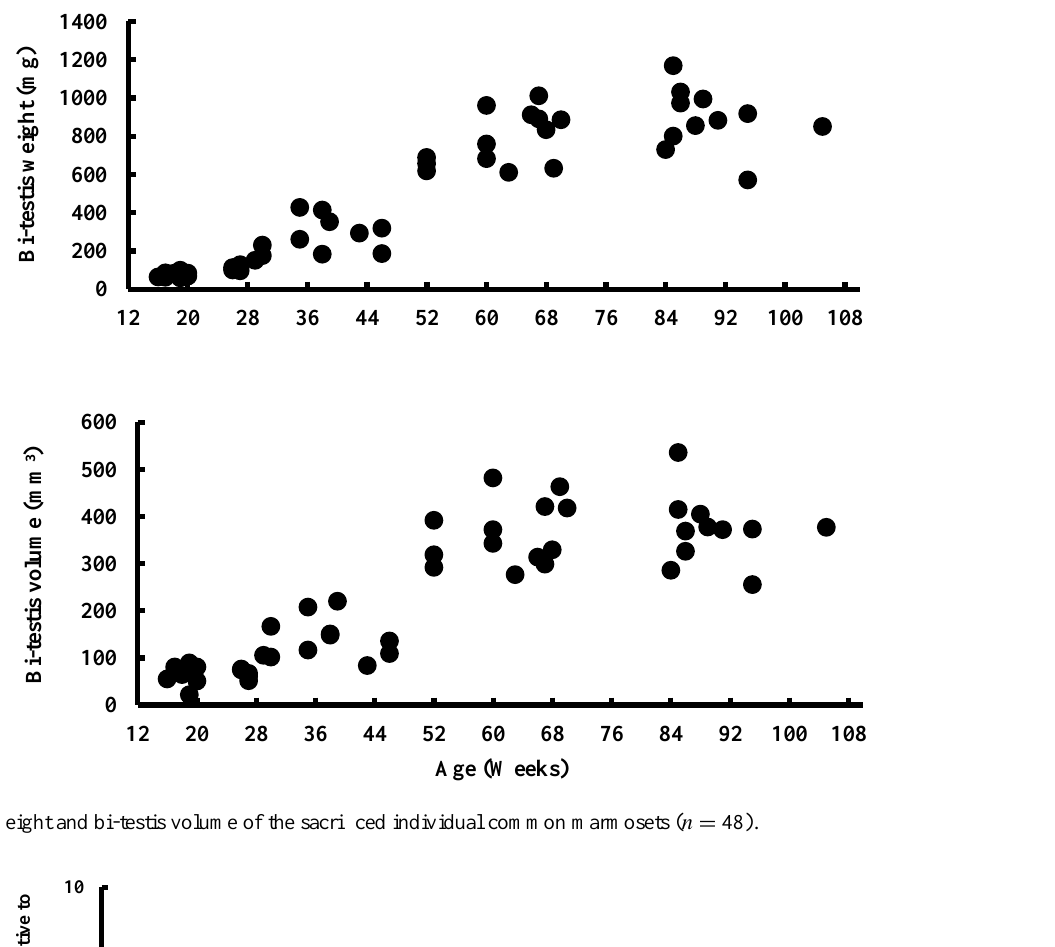
Figure 8. Bi-testis weight and bi-testis volume of the sacrificed individual common marmosets ( n = 48).